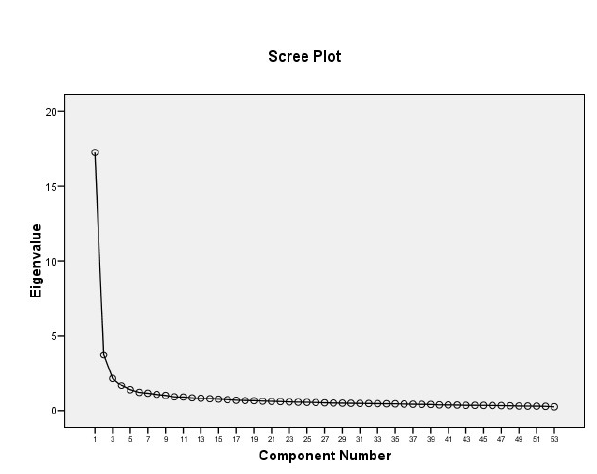
Fig. 2 Scree plot of factors influencing creativity